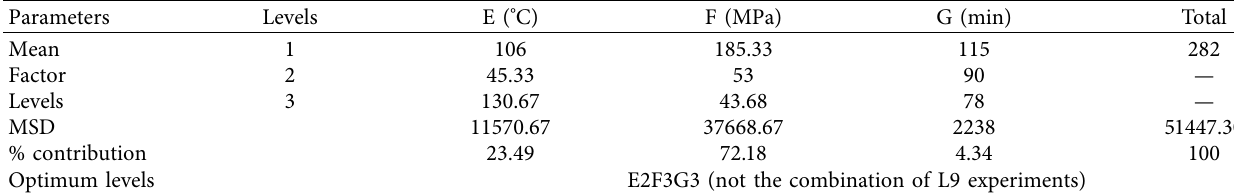
Table 10: Pareto ANOVA outcome for all